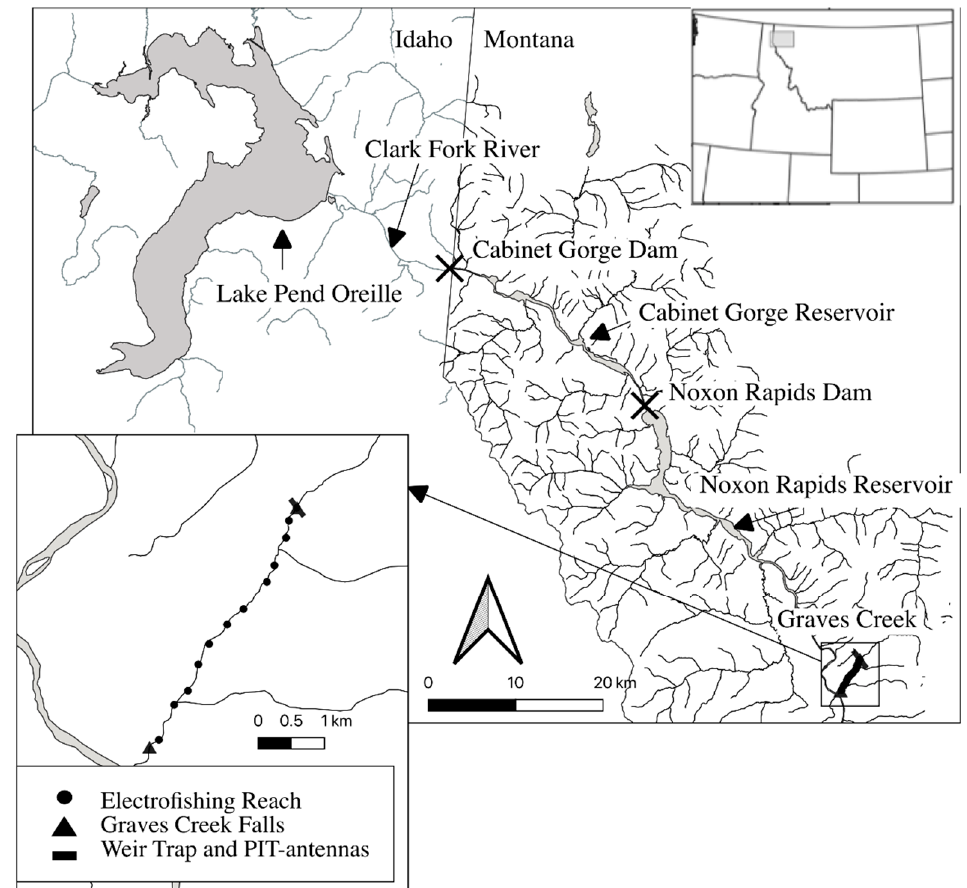
Figure 1. The lower Clark Fork River watershed, with major lakes and streams in Montana (1:100,000 scale) and Idaho (1:250,000 scale). The lower left inset map depicts the study area on Graves Creek, with the location of the sampling reaches. The upper right inset map depicts the location of the study relative to the state of Montana. The maps were created using QGIS 3.4.7, with layers from the U.S. Geological Survey (USGS) National Hydrography Dataset.